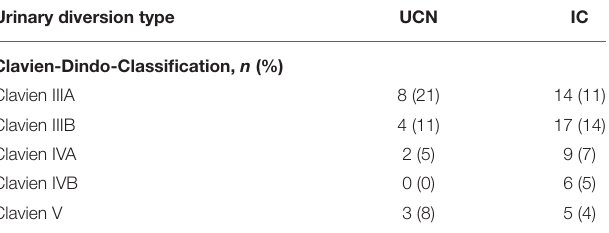
TABLE 3 | Complications.